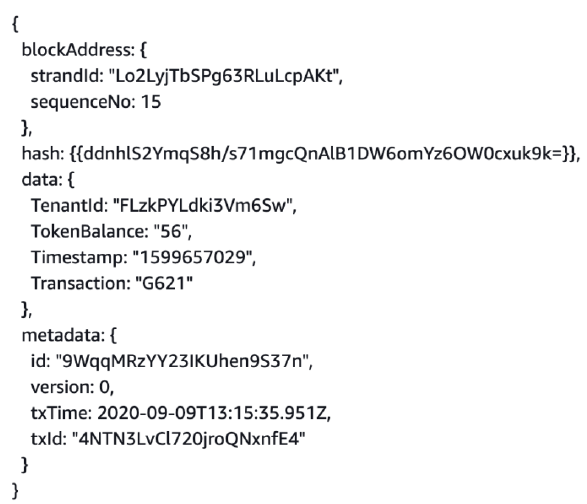
Figure 8. The output of “TokenBalance” table history.